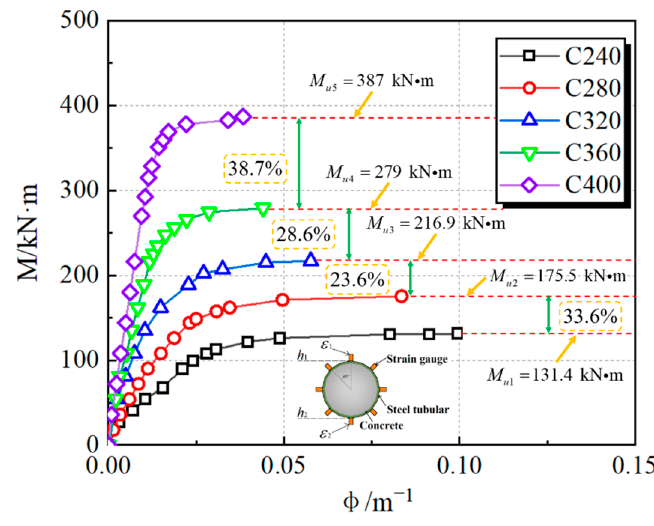
Figure 7. M ‐ϕ curves of CFHST beams.